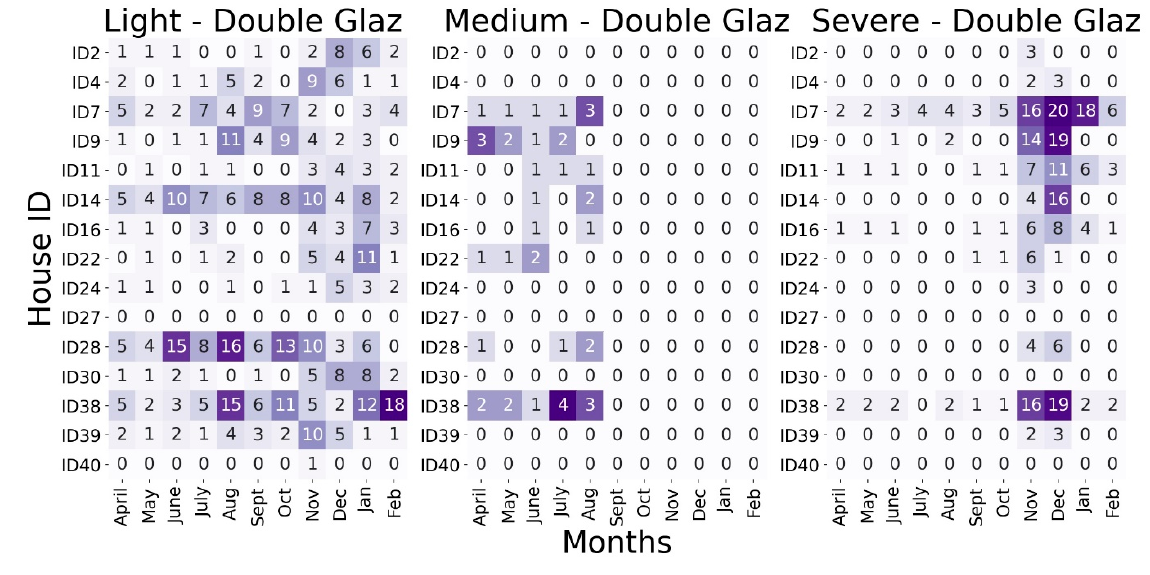
Figure A7. Results of the underheating criteria 2 applied to the models with double glazing. The X axis shows the months, and Y axis shows the house ID. The intersection of both shows the number of underheated light (left), medium (middle), and severe (right) days in that month.